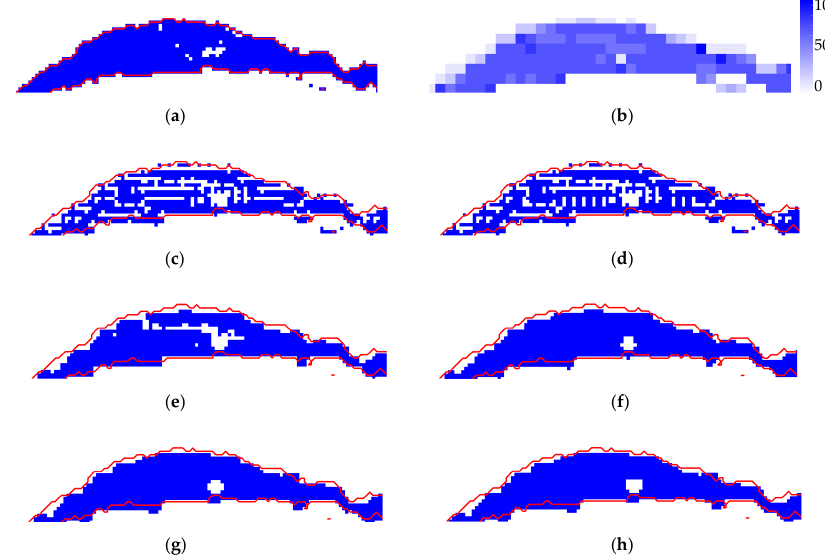
Figure 21. Sub-pixel maps obtained from real water fractions based on OBA-NDWI algorithm for Noce River: ( a ) reference map, ( b ) real water fractions based on OBA-NDWI algorithm; sub-pixel maps of ( c ) PS, ( d ) MBPS, ( e ) majority filter applied on MBPS, ( f ) bilinear, ( g ) bicubic, and ( h ) lanczos3 algorithms, ZF = 5.